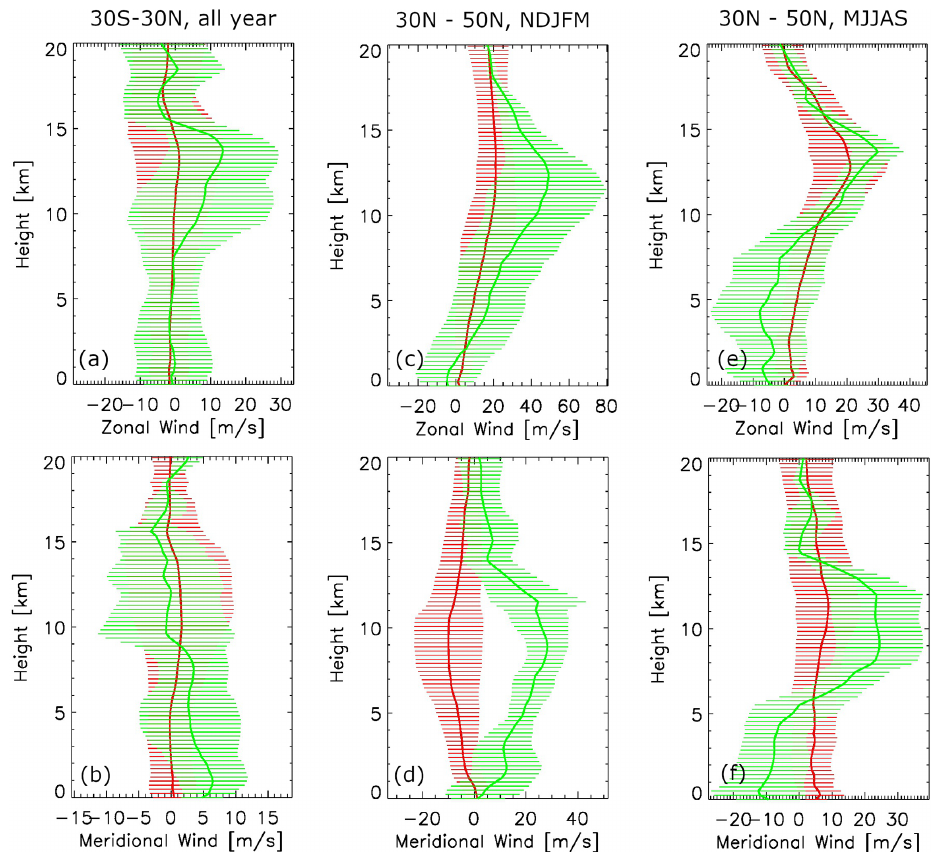
Figure 5. Same with Fig. 4, except for zonal wind (a, c, e) and meridional wind (b, d, f) .